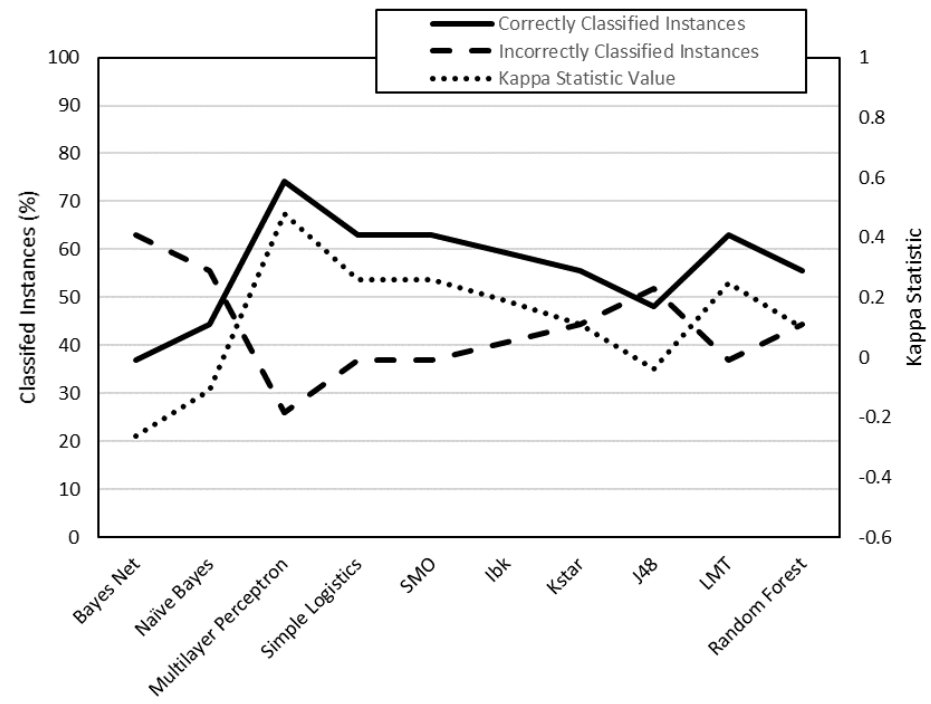
Figure 5. Evaluation of the models generated by WEKA for R a,0,XZ data (cross-validation, 10 folds).